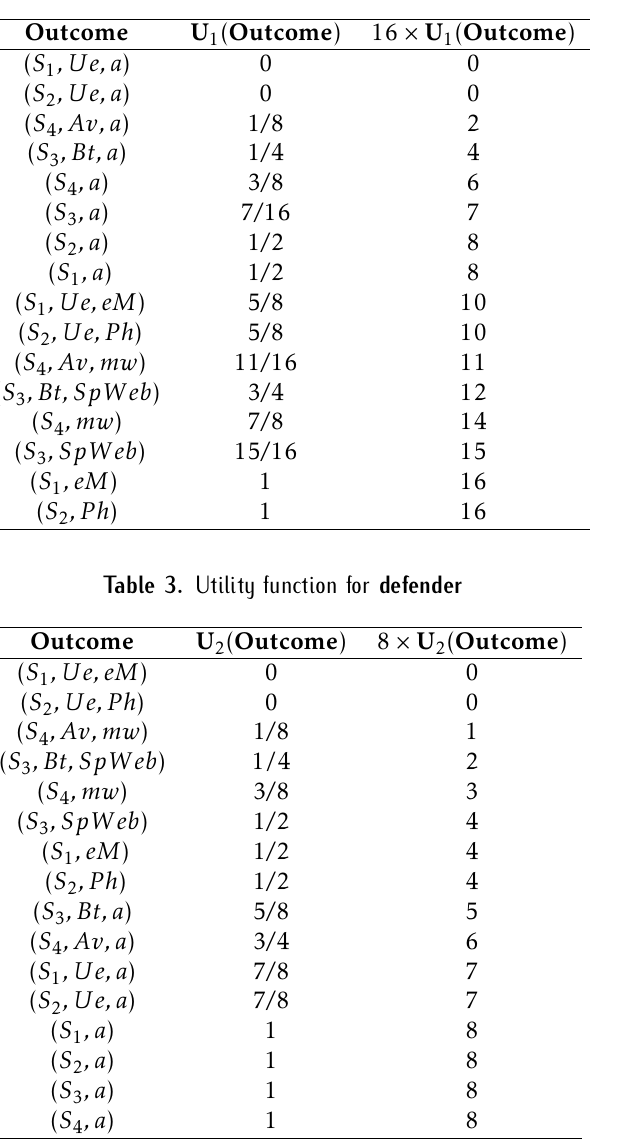
Table 2. Utility function for phisher